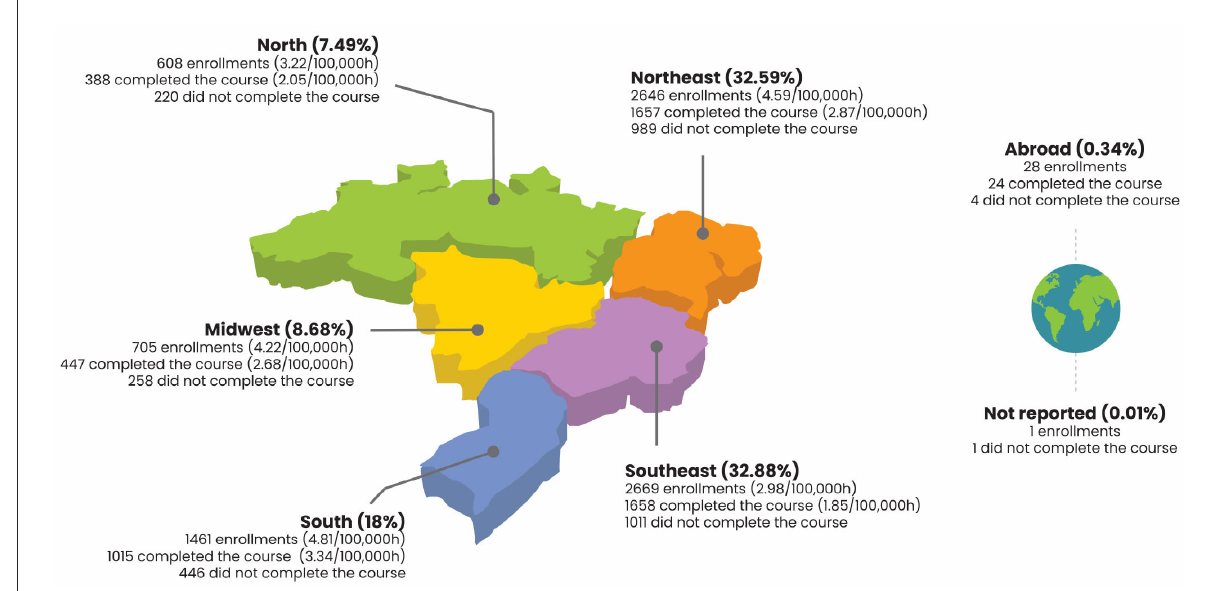
FIGURE1 Analysis of course participants and enrollments by Brazilian region.